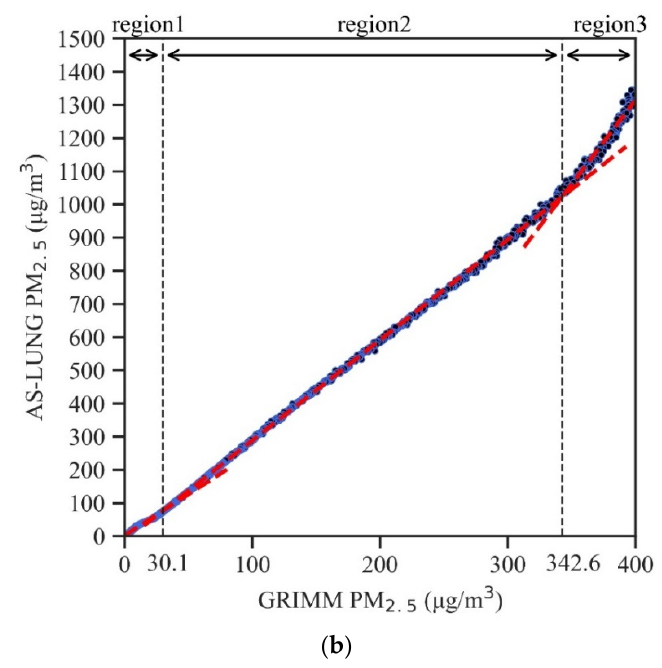
Figure 4. An example of raw PM 2.5 data in the chamber experiments with incense with segmented regressions for ( a ) 0.1–200 µg/m 3 and ( b ) 0.1–400 µg/m 3 ; the regions indicated are the concentration ranges for the different regression equations.